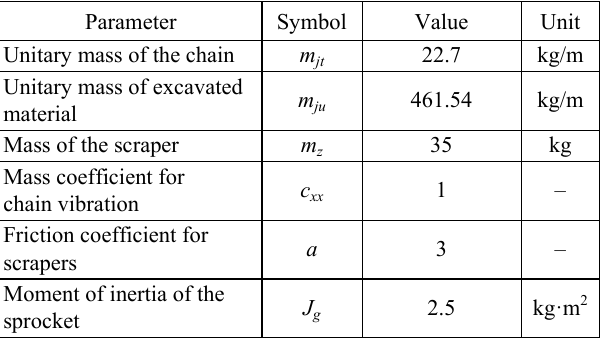
Table 2. Parameters of mass model